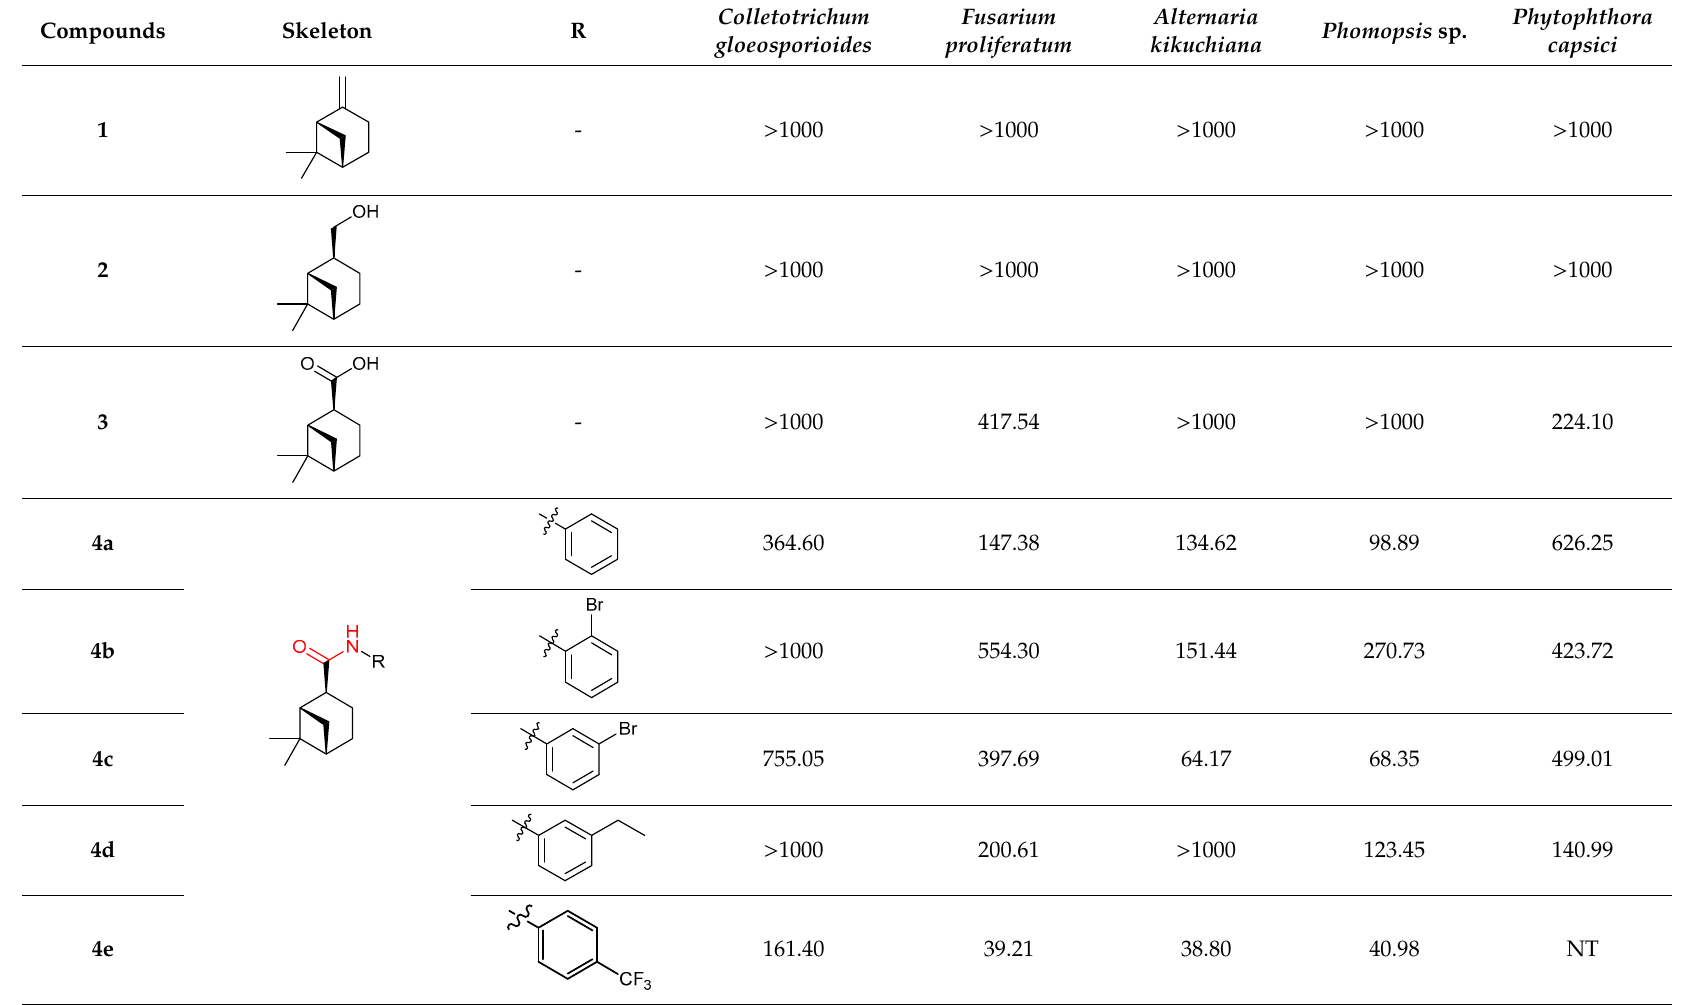
Table 1. IC 50 values of β -pinene-based derivatives against five plant pathogens ( μ mol/L). Compounds